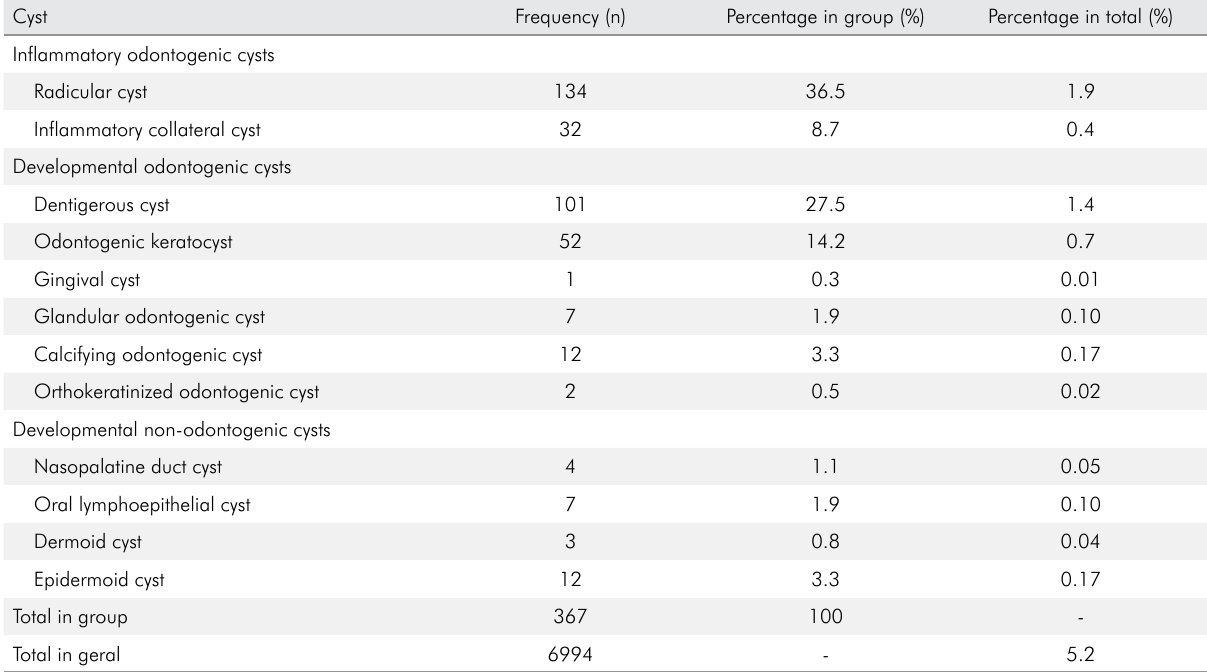
Table 1. Frequency distribution of odontogenic and non-odontogenic cysts. Cyst Frequency (n) Percentage in group (%) Percentage in total (%) Inflammatory odontogenic cysts Radicular cyst